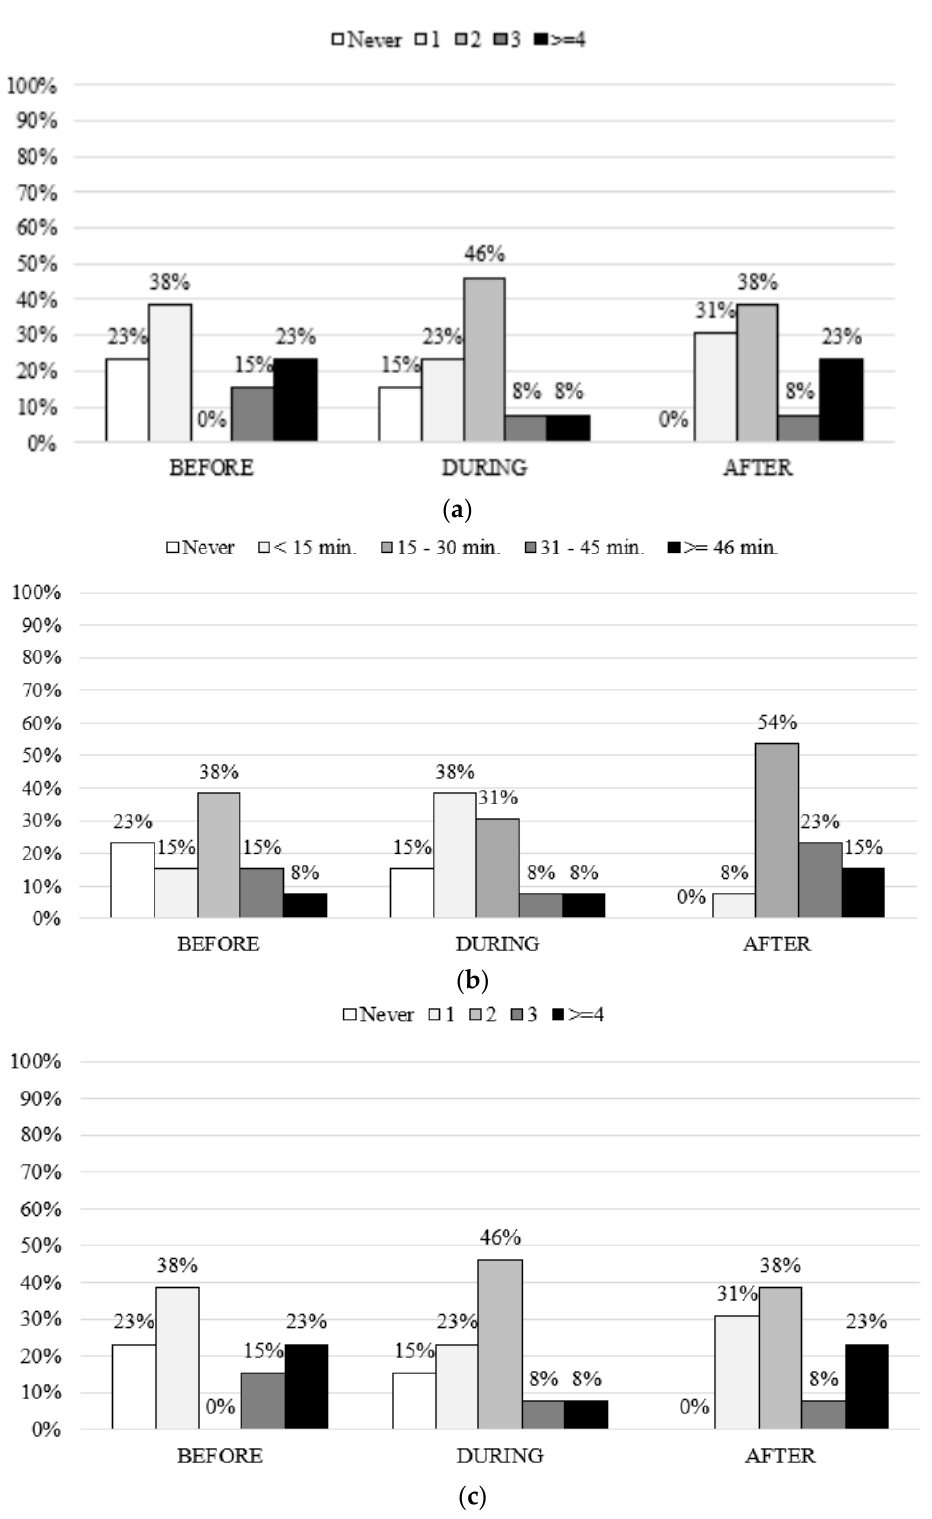
Figure 3. Exercise training preferences at baseline regarding ( a ) frequency (times/week), ( b ) duration, and ( c ) intensity.